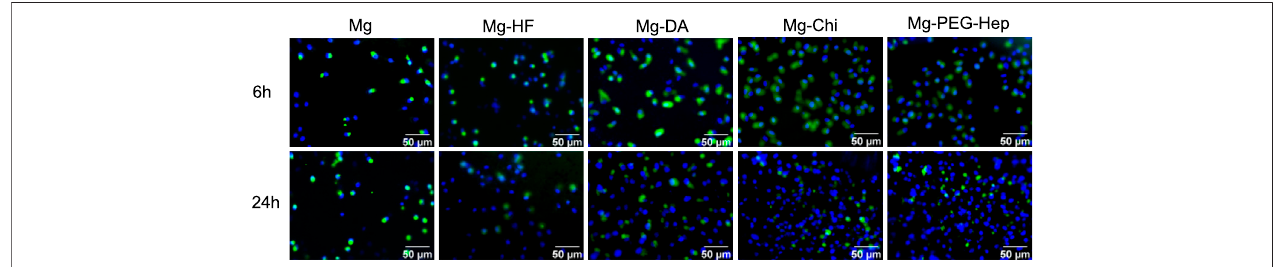
FIGURE 6 | SEM images of the endothelial cells adhered on the different samples surfaces for 6 and 24 h, respectively.